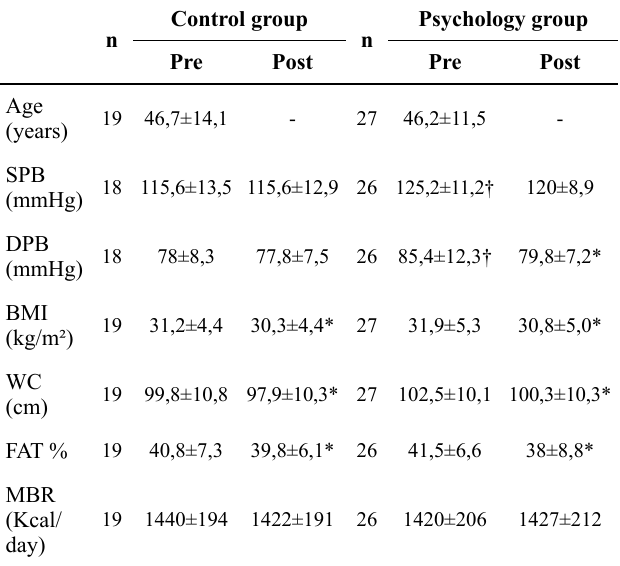
Table 1: Systolic and diastolic blood pressure (SBP, DPB), body